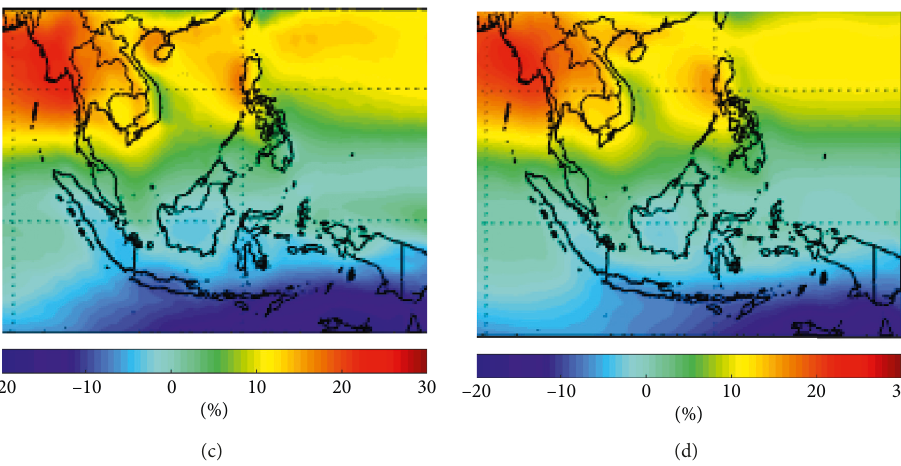
Figure 11: Comparisons of the mean seasonal cycle amplitudes of precipitation (Season-Amp-Ps) for years 1960–1999 of (a) observations, (b) CNRM-CM5-2, (c) 6-GCM-Ensemble, and (d)